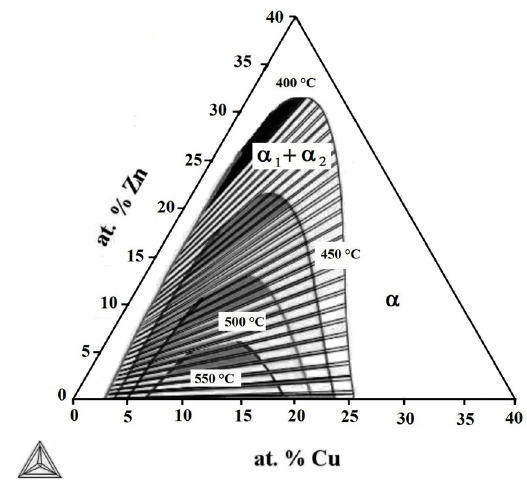
Figure 2. Calculated equilibrium Al-Zn-Cu miscibility gap diagram at different